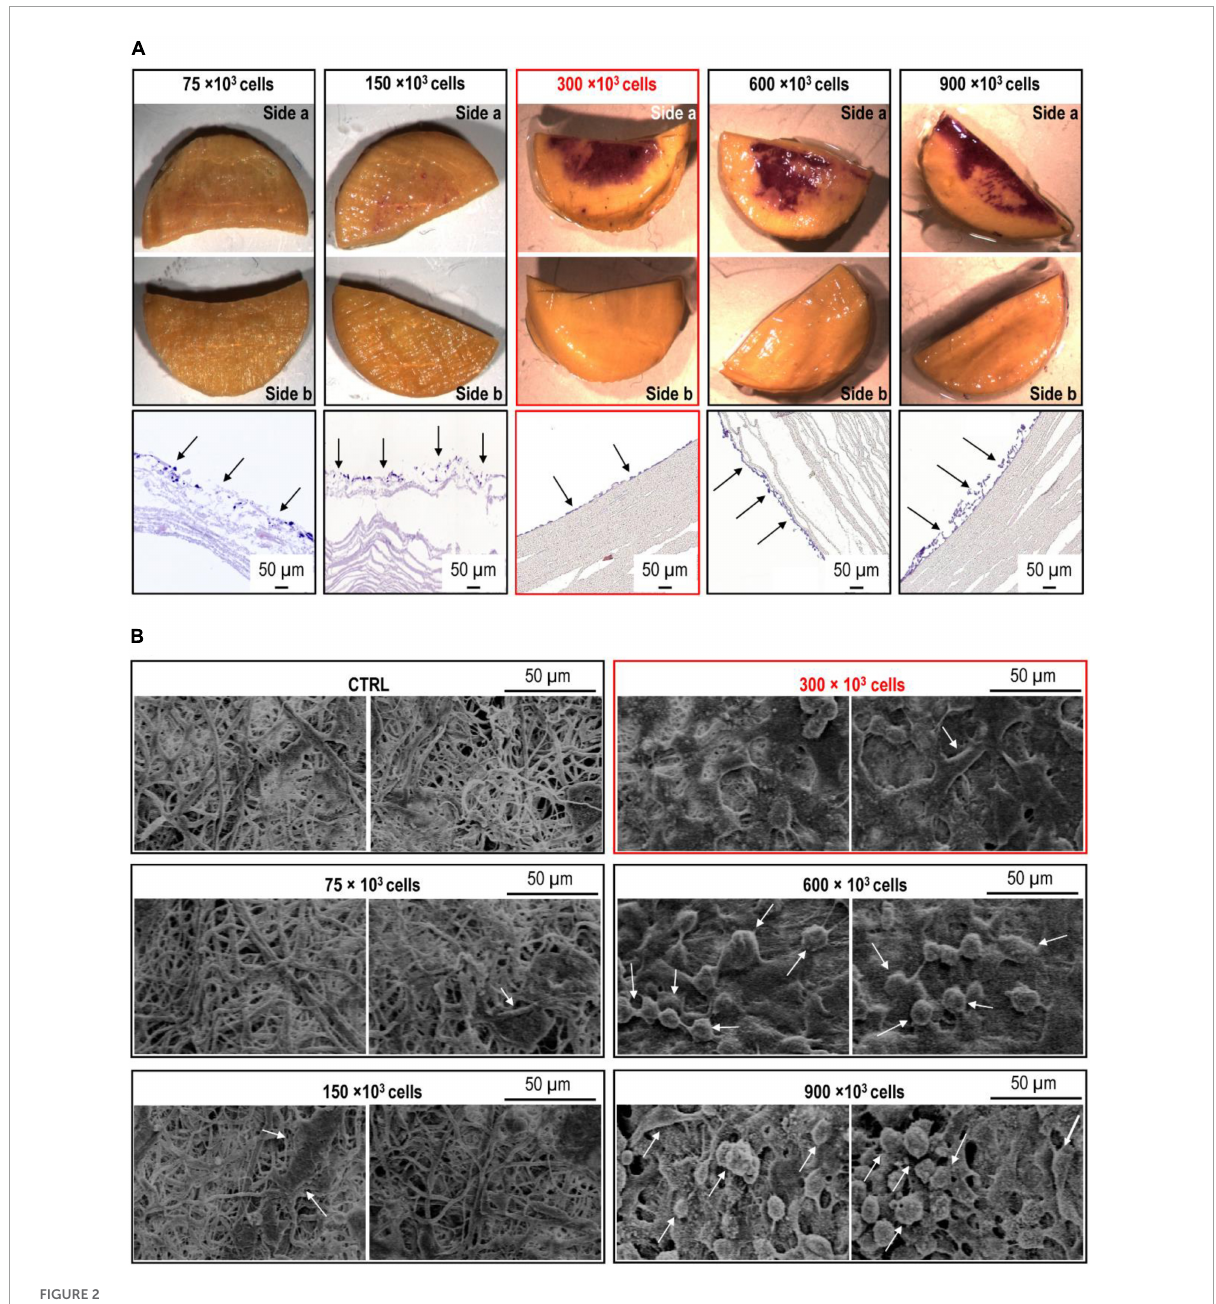
FIGURE2 Optimization of ECs seeding onto circular silk scaffold patches. (A) Increasing amounts (75 × 10 3 –900 × 10 3 ) of cells were seeded onto the circular silk scaffold patches produced as in Figure 1D . The pictures on the upper side of the panel show the MTT staining of both sides of the scaffold halves, where the increasing purple color indicates an increased coverage of the seeding surface (side a). The lack of staining on sides b indicates that there was no migration of the cells on the opposite scaffold side. The micrographs on the bottom part of the panel show the appearance of the endothelial cell (EC) layer as observed in transversal section of the scaffold. It is evident the formation of an EC monolayer at 300 × 10 3 ECs concentration. (B) SEM micrographs of the sides a of the silk scaffold circular patches cellularized with the increasing amounts of ECs. Also in this case, 300 × 10 3 was the optimal cell concentration, favoring the formation of a monolayer made of firmLy adhering